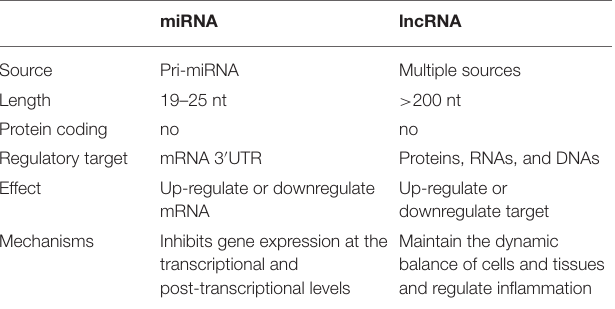
Frontiers in Medicine |